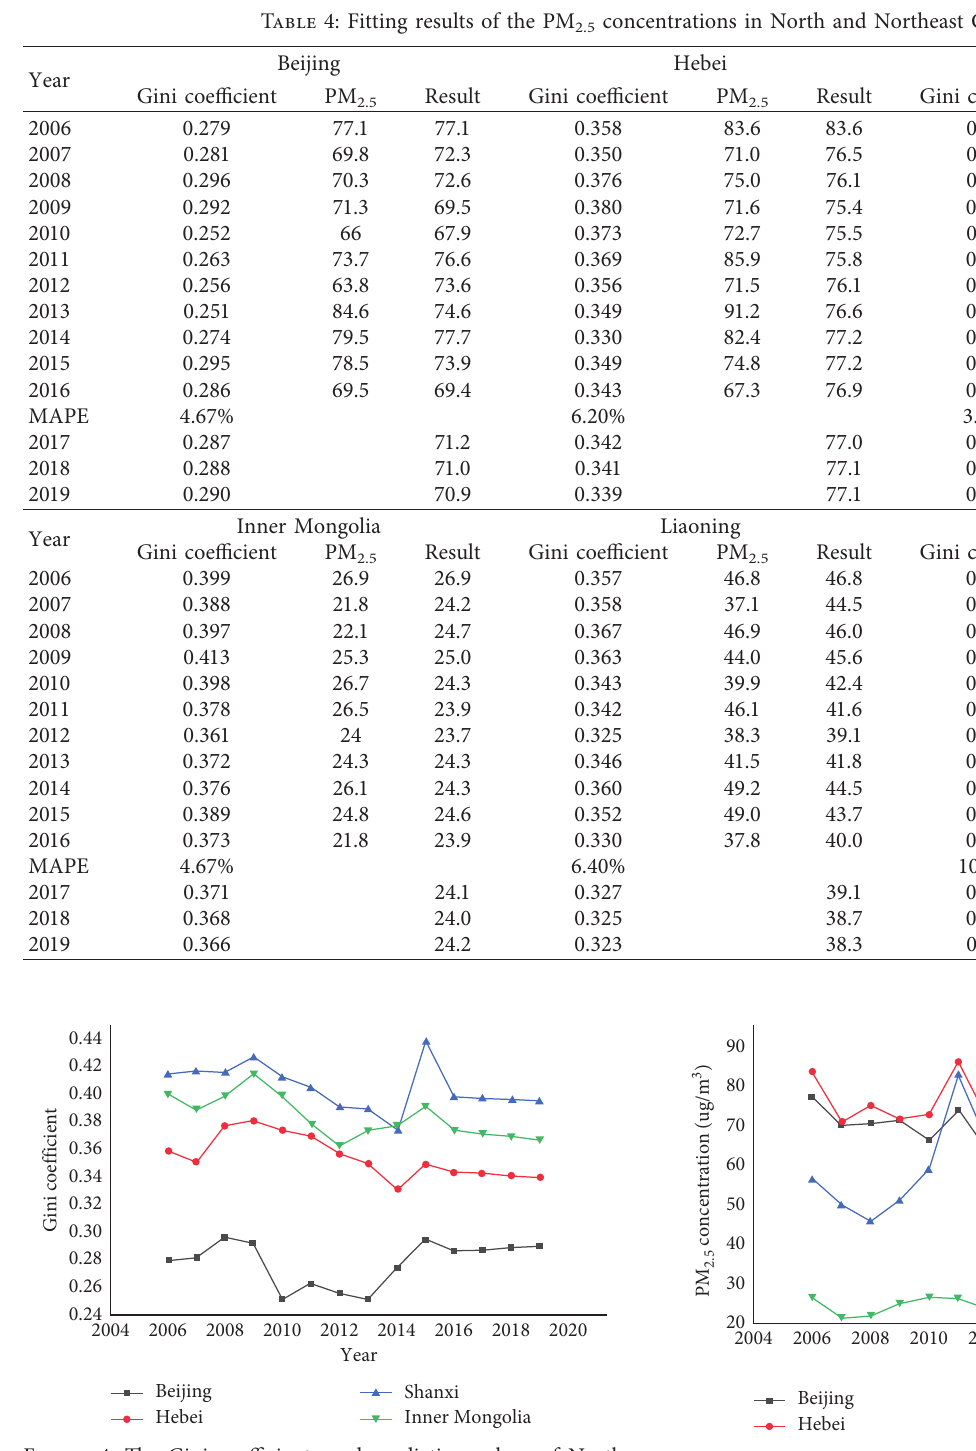
Figure 5: The PM 2.5 concentrations and prediction values of North